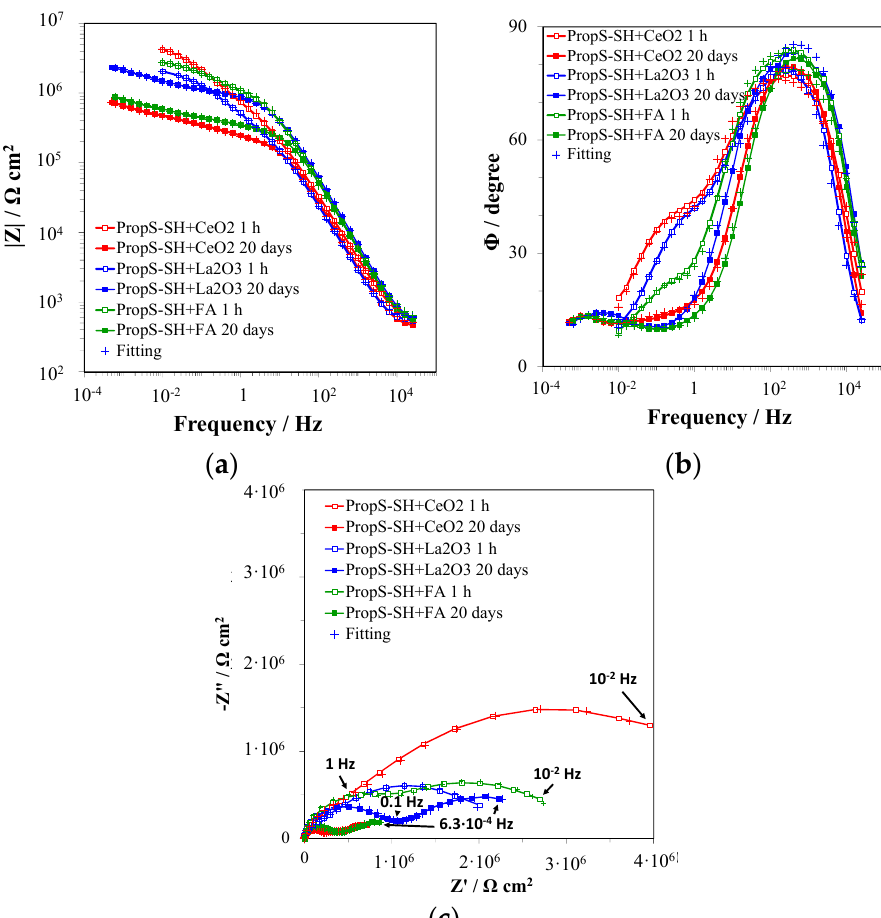
Figure 9. Bode ( a , b ) and Nyquist ( c ) plots recorded on bronze protected by PropS-SH coatings containing CeO 2 , La 2 O 3 and FA in ARx10 at 30 °C. Squares and circles represent experimental data and crosses are the result of the fitting.